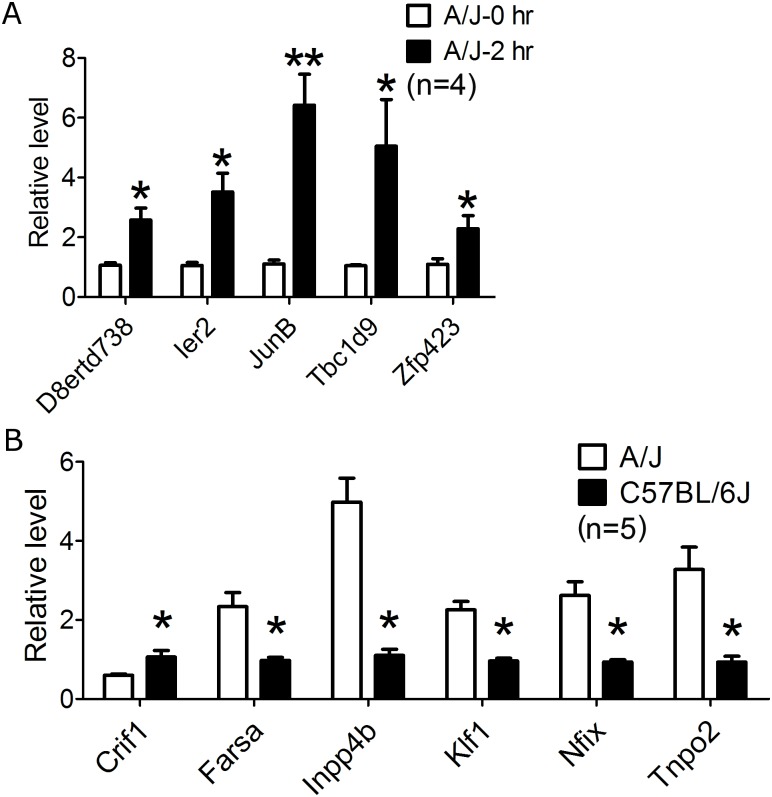
qPCR validation of murine candidate genes.(A) qPCR validation of genes identified by Strategy 1. Genes within the QTL region that were differentially expressed between A/J and C57BL/6J mice only in the setting of S. aureus infection by microarray (S1 Table) underwent qPCR validation. qPCR validated five genes (D8ertd738, Ier2, JunB, Tbc1d9, Zfp423) with expression patterns in A/J and C57BL/6J (n = 4 in each group) that were consistent with microarray results. At 2 hours post S. aureus infection, the fold difference of A/J-2hr vs A/J-0hr was D8ertd738 (2.58fold, p<0.05), Ier2 (3.51 fold, p<0.05), JunB (6.42 fold, p<0.01), Tbc1d9 (7.05 fold, p<0.05) Zfp423 (2.29 fold, p<0.05). “*” represents p<0.05, “**” represents p<0.01. (B) qPCR validation of genes identified by Strategy 2. Genes within the QTL region that were differentially expressed between A/J and C57BL/6J mice in both uninfected and S. aureus infected states by microarray (S2 Table) underwent qPCR validation. qPCR validated six genes (Crif1, Farsa, Inpp4b, Klf1, Nfix, and Tnpo2) with expression patterns in A/J and C57BL/6J (n = 5 in each group) that were consistent with microarray results. At 3 hours post S. aureus infection, the fold difference of A/J vs C57BL/6J was Crif1 (0.6fold, p<0.05), Farsa (2.4fold, p<0.05), Inpp4b (4.5fold,p<0.05), Klf1 (2.4fold, p<0.05) Nfix (2.8fold, p<0.05), and Tnpo2 (3.5fold, p<0.05). “*” represents p<0.05. All mice were 8-week old males.